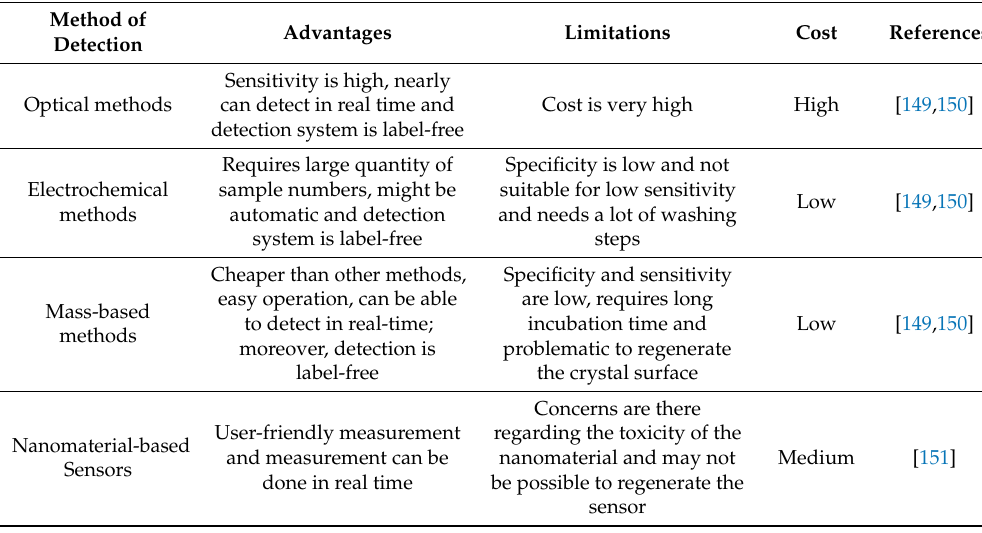
Table 3. Summary of various biosensors with their advantages and